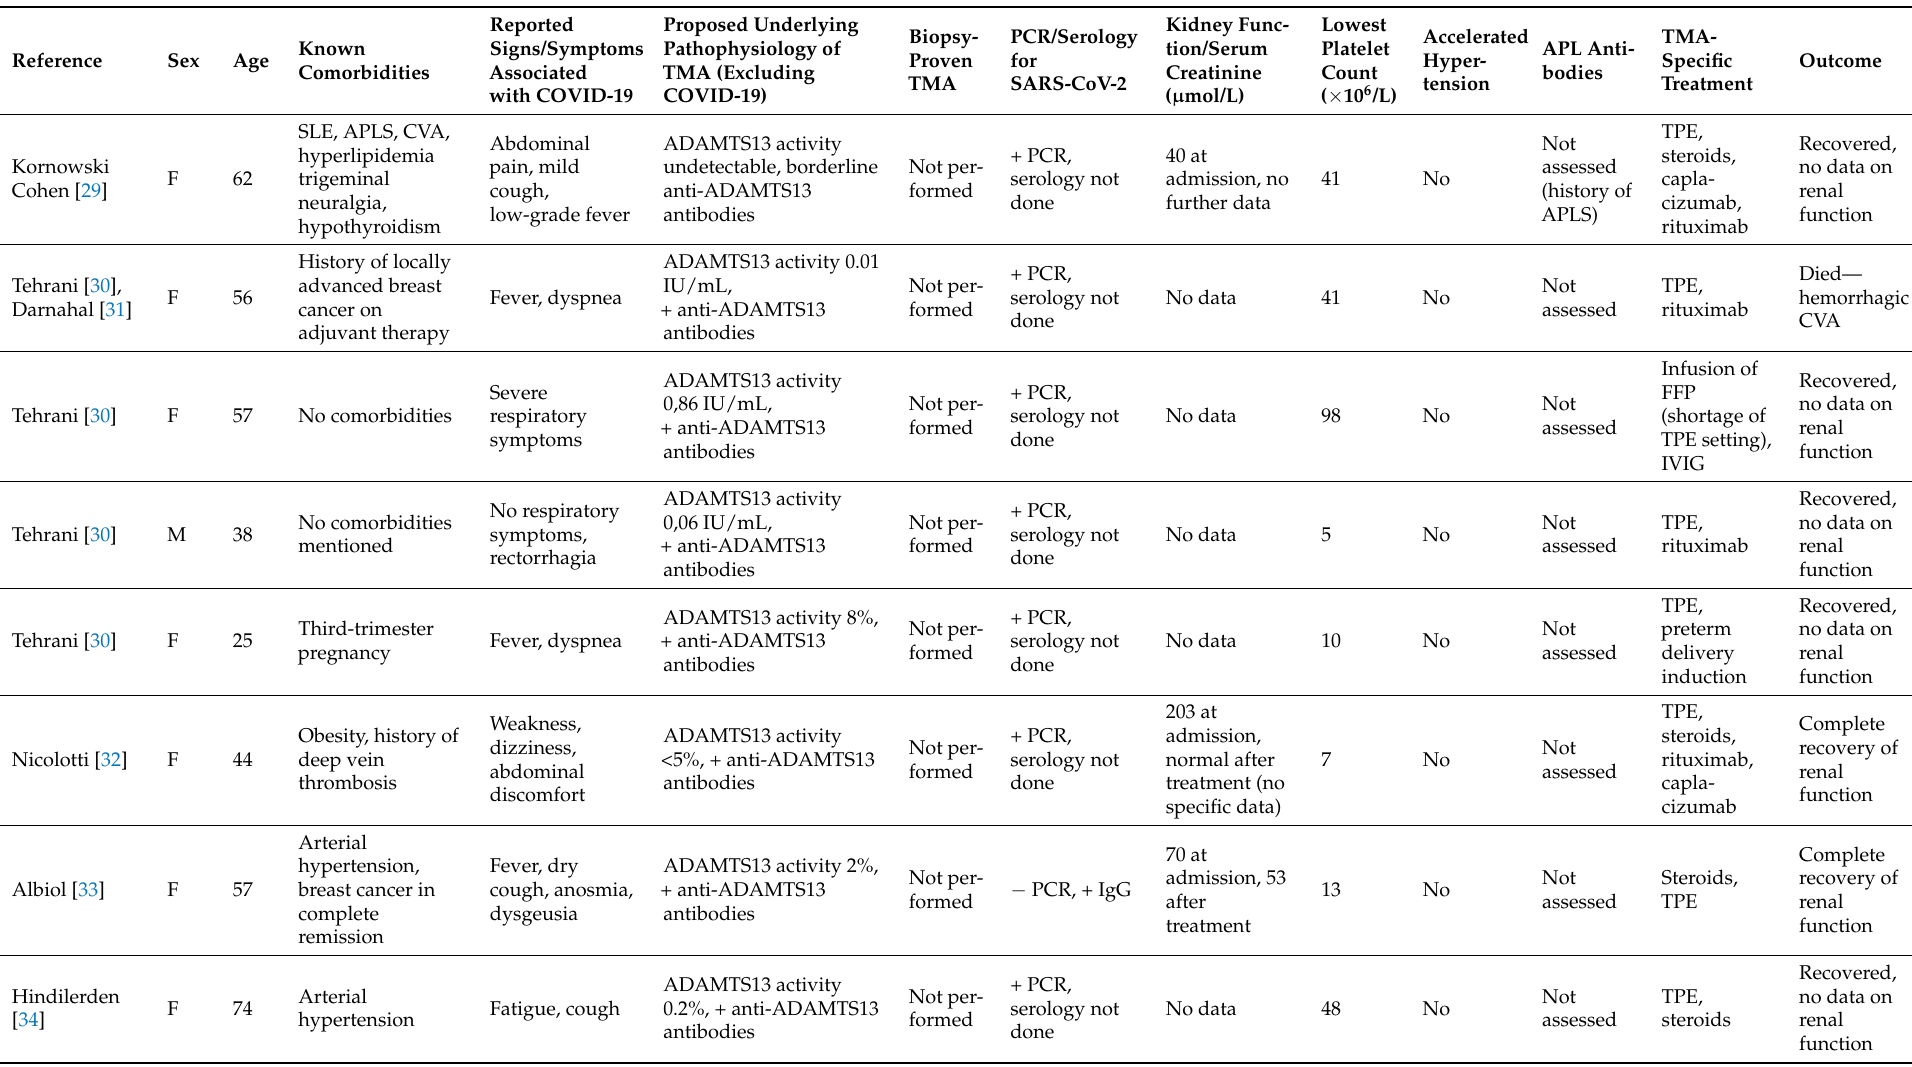
Table 1. Summary of demographic and clinical characteristics of patients presenting as COVID-19-associated